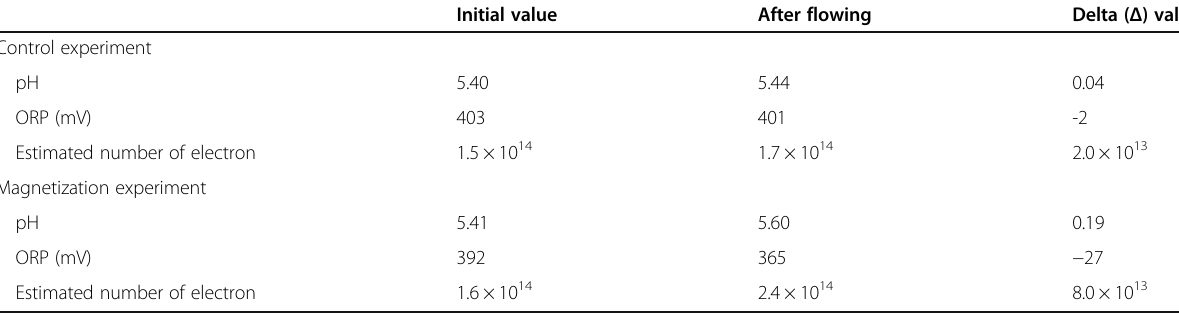
Table 2 Estimated number of electron generated in water with magnetic effect based on pH and